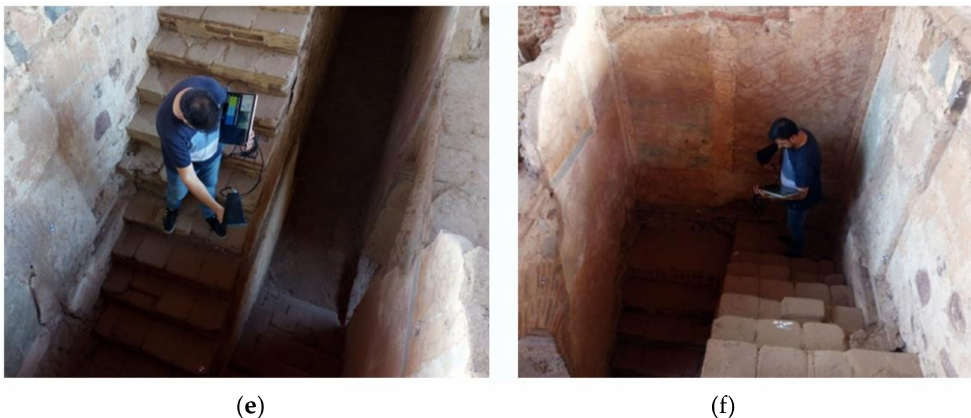
Figure 6. Total station ( a ) and target model ( b ) used to co-ordinate control points; Faro Focus3D X 330 laser scanner recording data in working areas 1 ( c ) and 3 ( d ); and data capture with the proposed system in working area 2 ( e , f